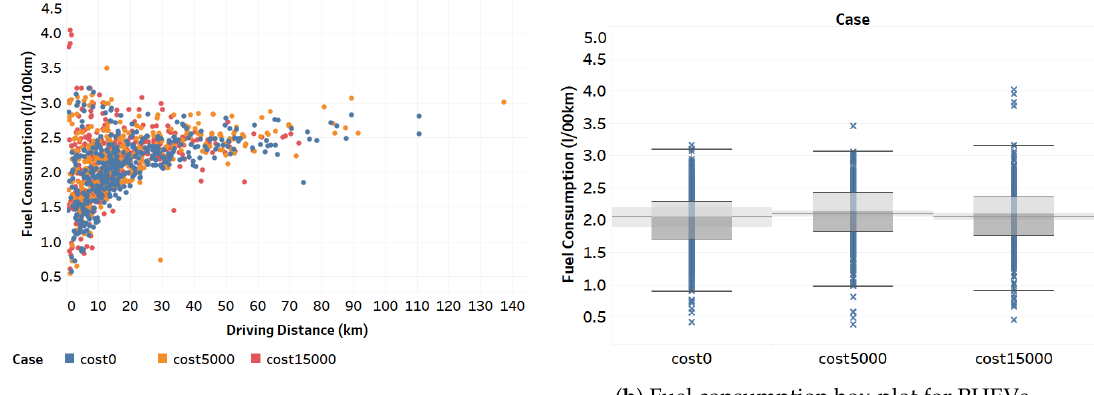
Figure 6. Fuel consumption distribution for PHEVs.